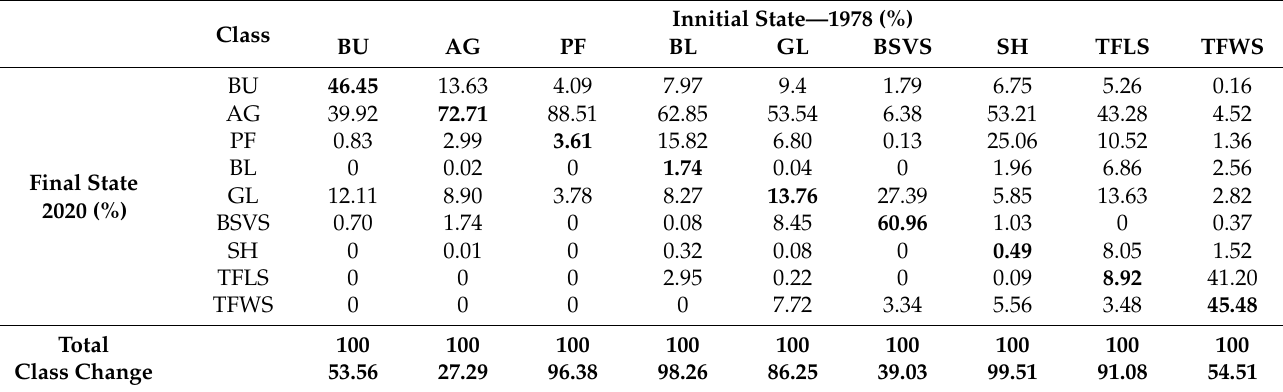
Table 6. The land cover change flow matrix (percentage) in the upper Manafwa watershed